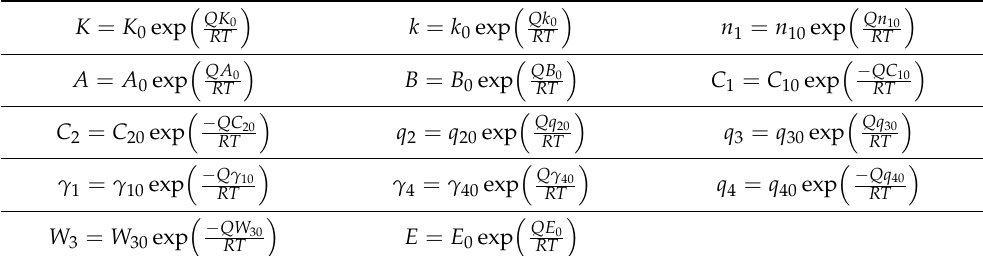
Table 2. The equation set of temperature-dependent material